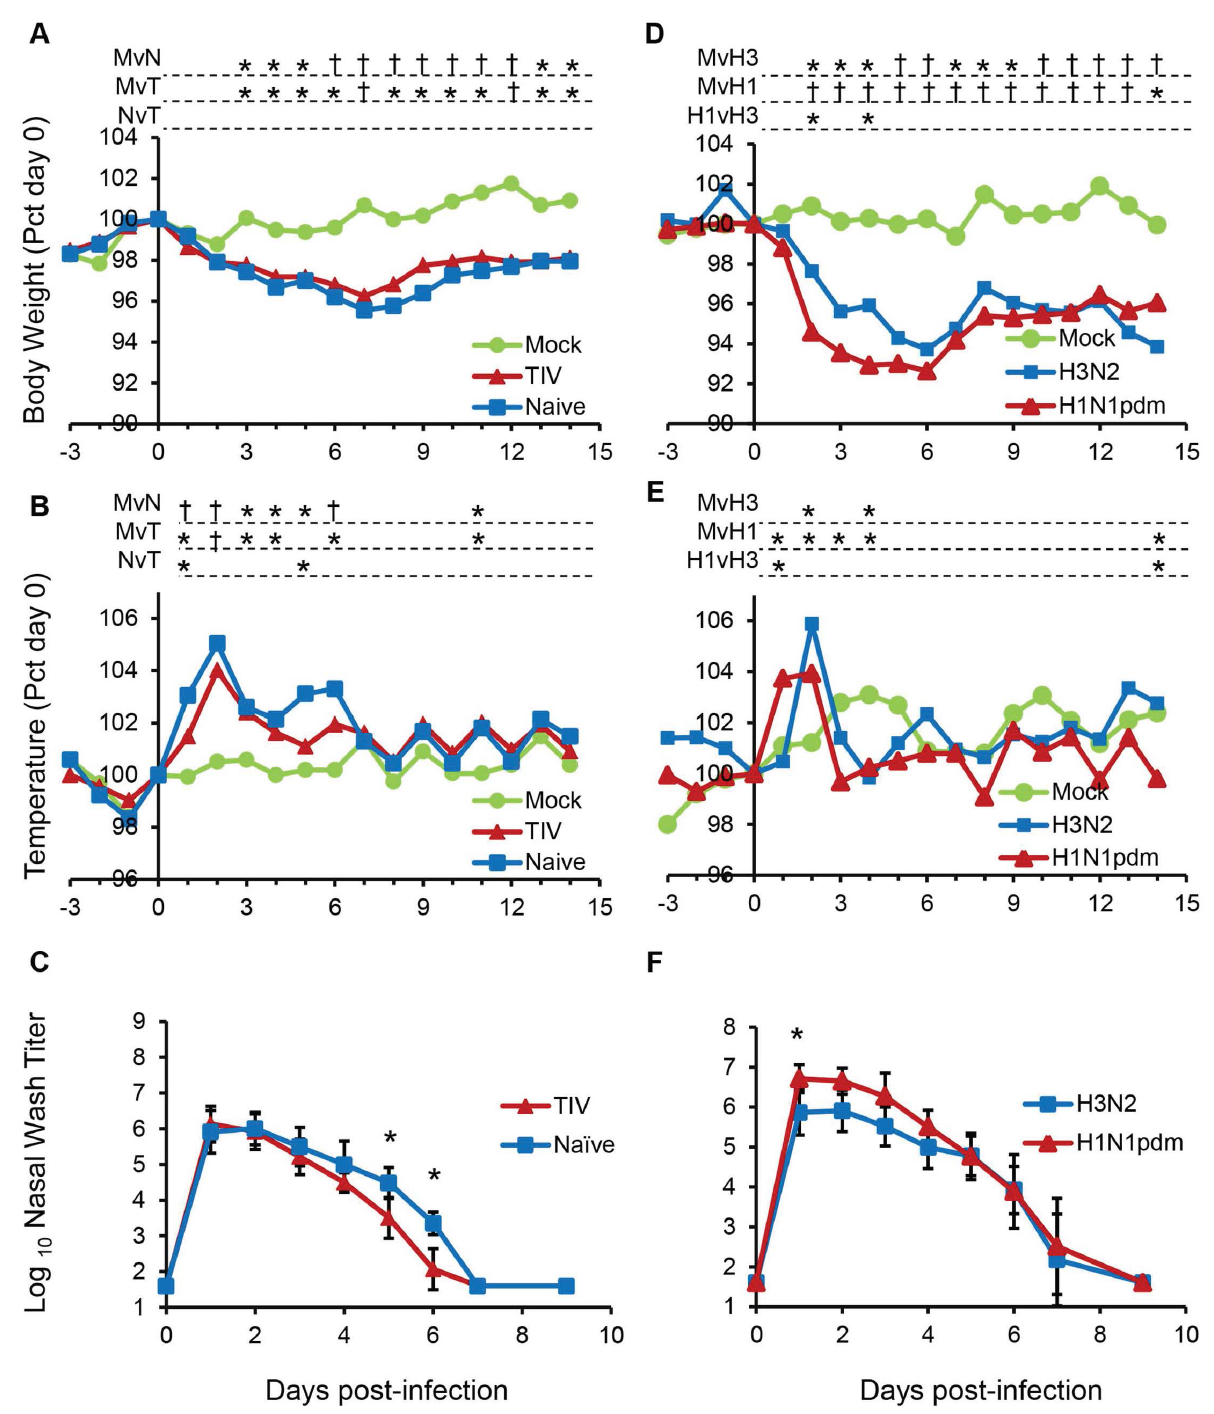
Figure 3. Clinical responses to infection. ( A–C ) Two weeks after booster vaccination, ferrets were challenged intranasally with 10 6 PFU of Perth/ 16. ( D–F ) Unvaccinated ferrets were challenged intranasally with 1 6 10 6 PFU of NY/21 or Perth/16. ( A, D ) Body weight and ( B, E ) temperature were measured daily. Data shown are normalized to the individual animals’ weight or temperature on the day of challenge (day 0). ( C, F ) Nasal washes were obtained on days 0–9 and virus titers in the nasal washes were measured. Error bars represent 95% confidence intervals. ‘‘Mock’’, unvaccinated mock-infected animals; ‘‘Naı¨ve’’, unvaccinated animals challenged with Perth/16; ‘‘TIV’’, vaccinated animals challenged with Perth/16. ‘‘H3N2’’, unvaccinated animals challenged with Perth/16; ‘‘H1N1pdm’’, unvaccinated animals challenged with NY/21. { indicates p , 0.0001; * indicates 0.0001 , p , 0.05. ‘‘MvN’’, comparing mock-infected ferrets to naı¨ve ferrets; ‘‘MvT’’, comparing mock-infected ferrets to ferrets vaccinated with TIV; ‘‘NvT’’, comparing naı¨ve ferrets to ferrets vaccinated with TIV; ‘‘MvH3’’, comparing mock-infected ferrets to ferrets infected with H3N2; ‘‘MvH1’’, comparing mock-infected ferrets to ferrets infected with H1N1pdm09; ‘‘H1vH3’’, comparing H1N1pdm09 infected ferrets to ferrets infected with H3N2.